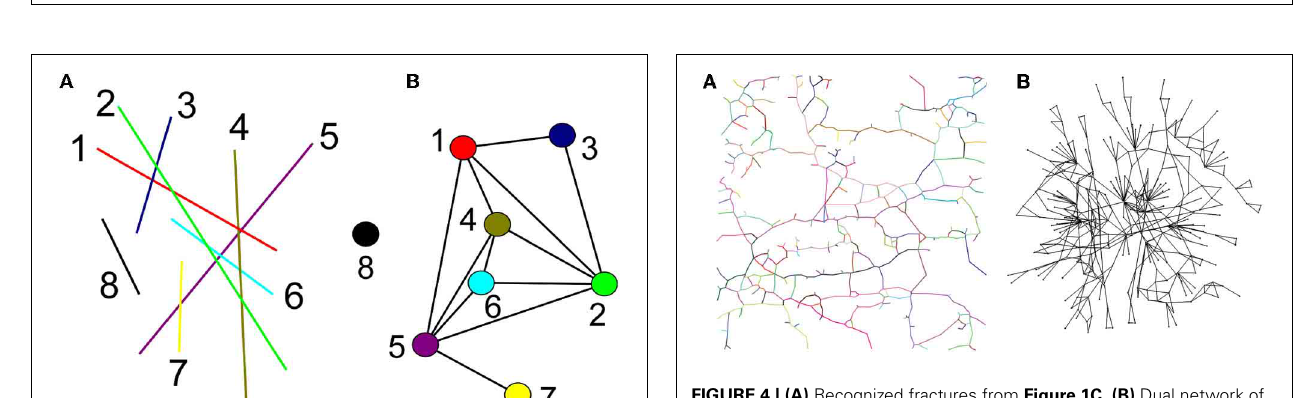
FIGURE 4 | (A) Recognized fractures from Figure 1C . (B) Dual network of the system of fractures in (A) , plotted with a force-directed algorithm [22] using the software tool Tulip 4.4.0 . In the dual network, the fractures are interpreted as nodes, and links are made between intersecting